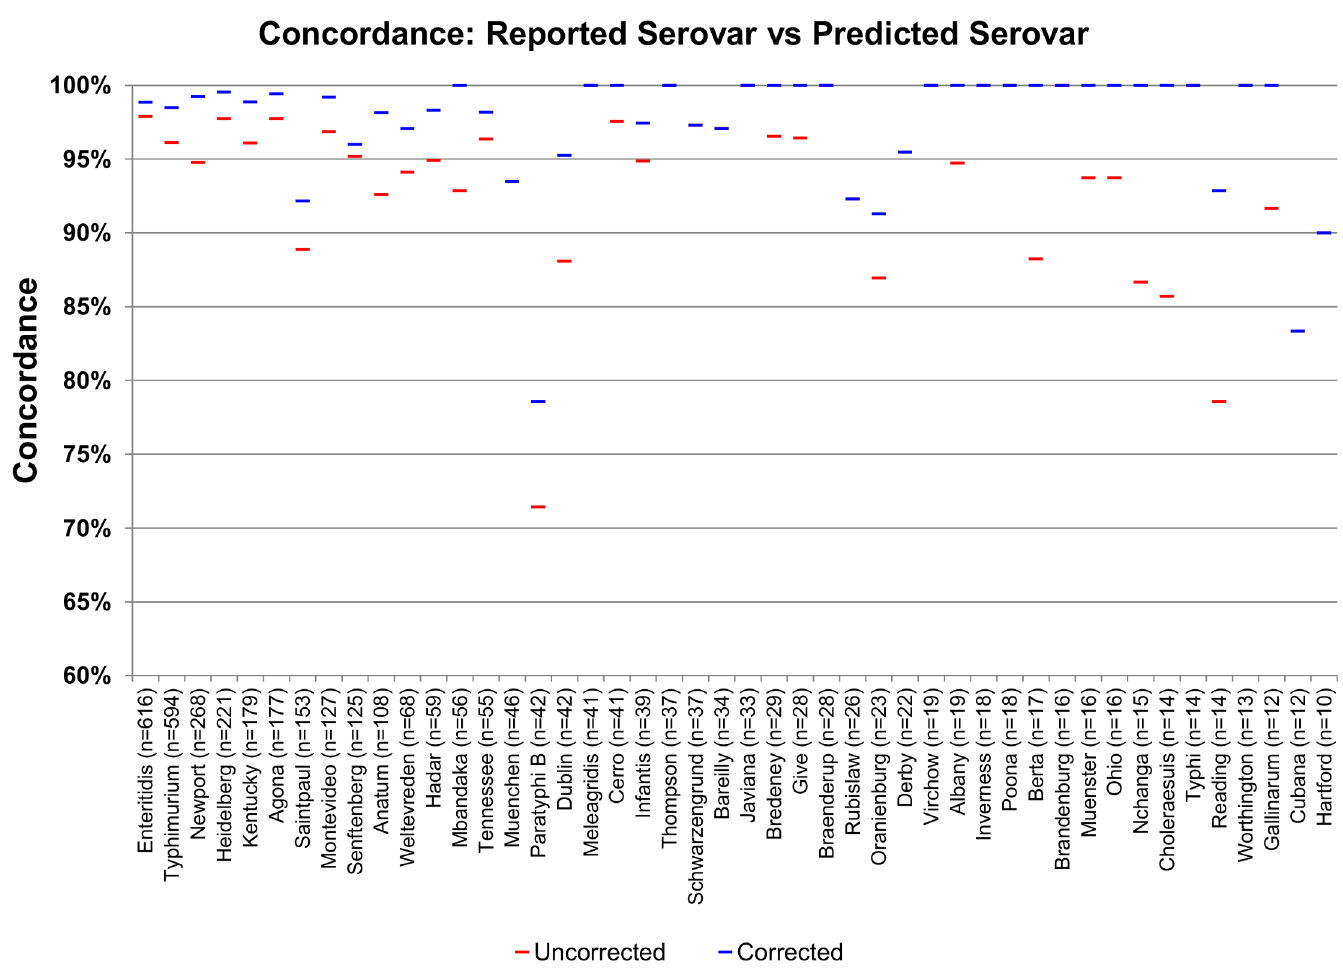
Fig 4. A high accuracy was observed for the SISTR serovar prediction pipeline. The prediction accuracy was assessed for serovars with 10 or more genome representatives and based only on genomes with metadata of sufficient quality to enable extraction of serovar information and those with high cgMLST data quality (n = 4,188). Accuracy was computed based on concordance between reported and predicted serovars. The “ uncorrected ” prediction accuracy, which is based on the original set of input genomes (n = 4,291) is shown in red. A “ corrected ” prediction accuracy, which is based on reclassification of genomes with Type 1 and 2 errors, and removal of genomes with Type 3 and 4 errors, is shown in blue. (note: where distinct corrected and uncorrected concordance values are not observable, both values are